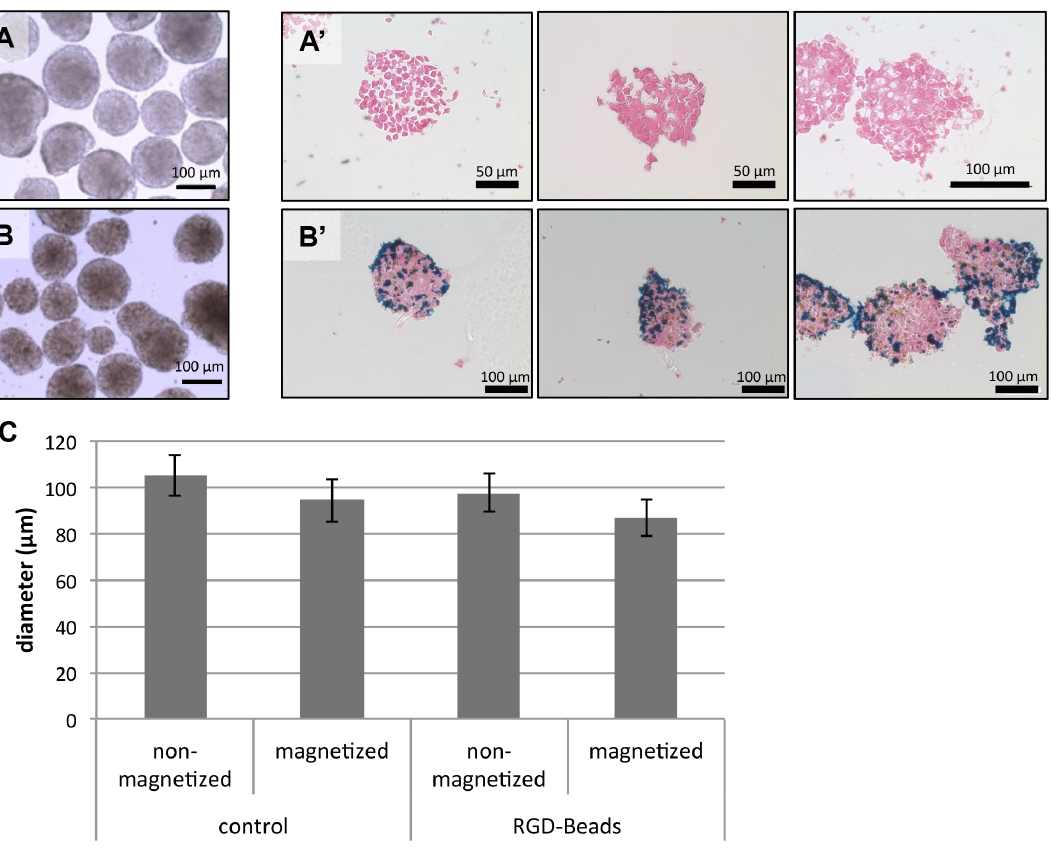
Fig. 1. Gross morphology of EBs with immobilized beads. Bead incorporation was confirmed by light micrographs (A–B) and Prussian Blue staining (A 9 –B 9 ). (C) Size comparison of EBs with or without